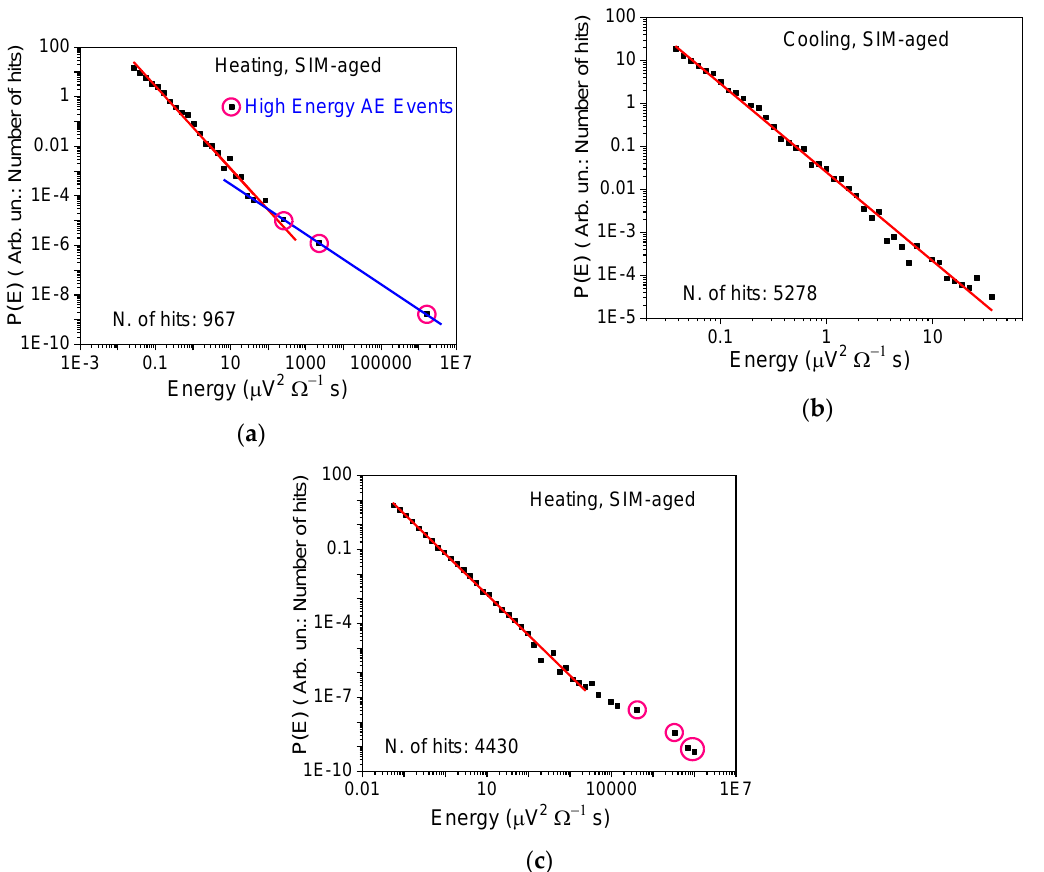
Figure 8. Energy distribution functions for heating ( a ) and cooling ( b ), obtained from acoustic measurements for SIM-aged ( m = 18 mg) Ni 51 Fe 18 Ga 27 Co 4 single crystals. ( c ) shows, for comparison, the distribution for heating on the SIM-aged sample with m = 47 mg (slopes of the lines, fitted to the first parts, are the same within the error bars).